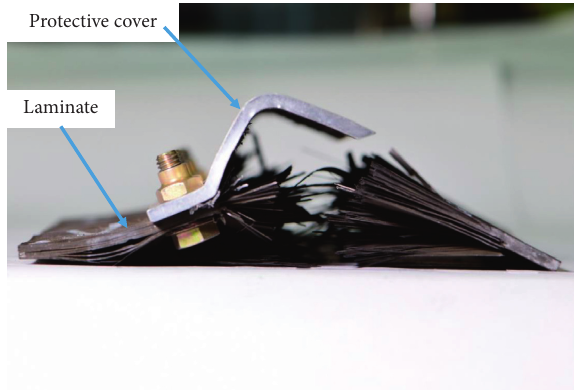
Figure 10: Cutting tests results of the laminate when the linear density of shaped charge is